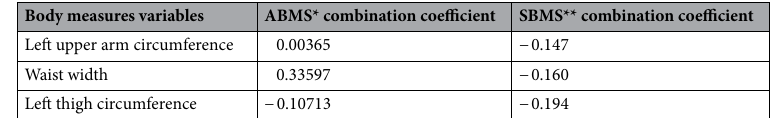
Table 3. Canonical correlation analysis between body measures and chronic diseases. ABMS adverse body measures score; SBMS sarcopenia-associated body measures score. * Canonical correlation coefficient = 0.294476 (p = 0.0026). ABMS = 0.00365 × Left upper arm circumference + 0.33597 × Waist width − 0.10713 × Left thigh circumference. **Logistic regression using backward selection method